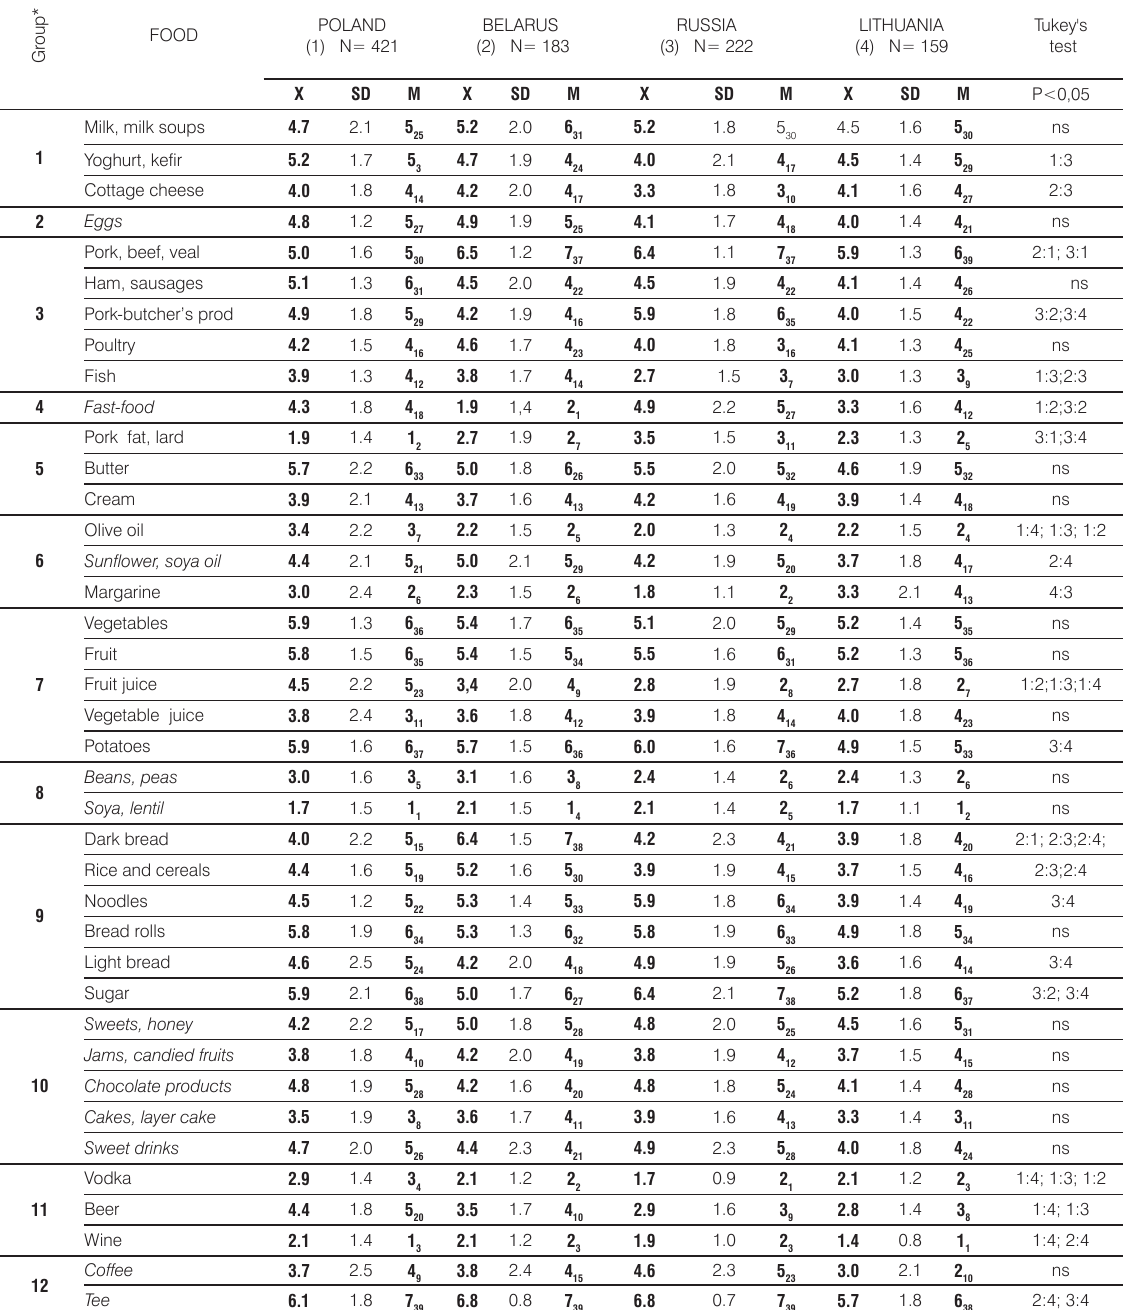
Table 5. The consumption frequency of examined food products in the group of